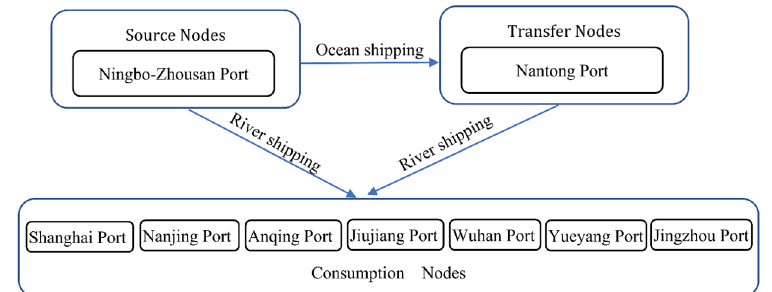
Figure 5. Classification, relationship, and transportation organization among city